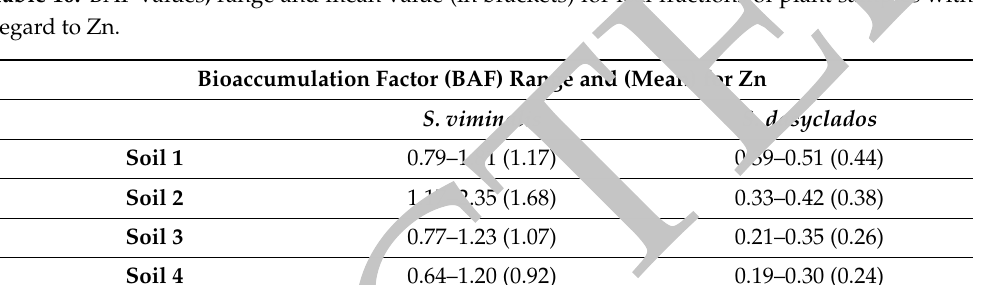
Table 10. BAF values, range and mean value (in brackets) for leaf fractions of plant samples with regard to Zn.